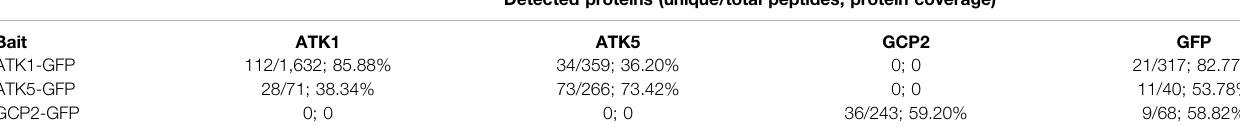
TABLE 1 | Recovery of associated polypeptide by immunoaf fi nity puri fi cation of ATK1-GFP and ATK5-GFP expressed in A . thaliana . It should be noted that a GCP2-GFP puri fi cation experiment performed previously (Miao et al., 2019) was used as a negative control here. By using ATK1-GFP, ATK5-GFP, and GCP2-GFP as baits, recovereduniqueandtotalpeptidesandpolypeptidecoveragearesummarizedhere.DetectedpeptidesoftheGFPtagprovidecomparisonsofbaitproteinrecoveryinthree puri fi cation attempts. Detected proteins (unique/total peptides; protein coverage)